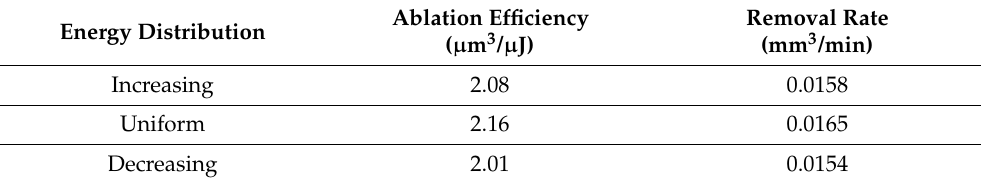
Table A5. Ablation efficiencies and removal rates of steel.